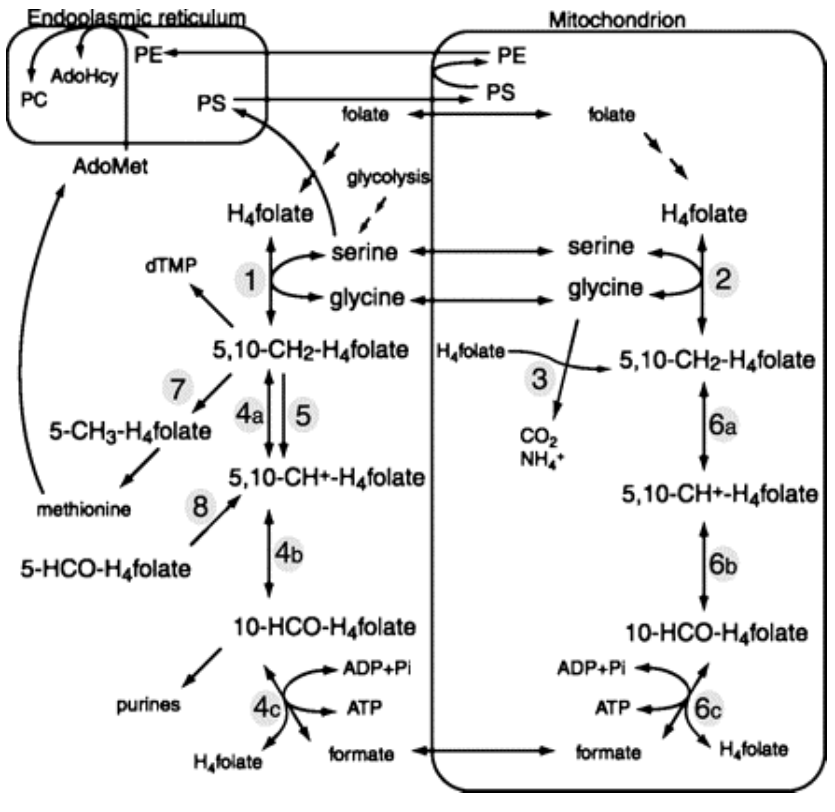
FIGURE 2. Intercompartmental flow of one-carbon units in Saccharomyces cerevisiae in the endoplasmic reticulum and the mitochondria. [Note: PC, phosphatidyl choline; AdoHcy, S-adenosylhomocysteine; PE, phosphatidylethanolamine; PS, phosphatidylserine; and AdoMet,